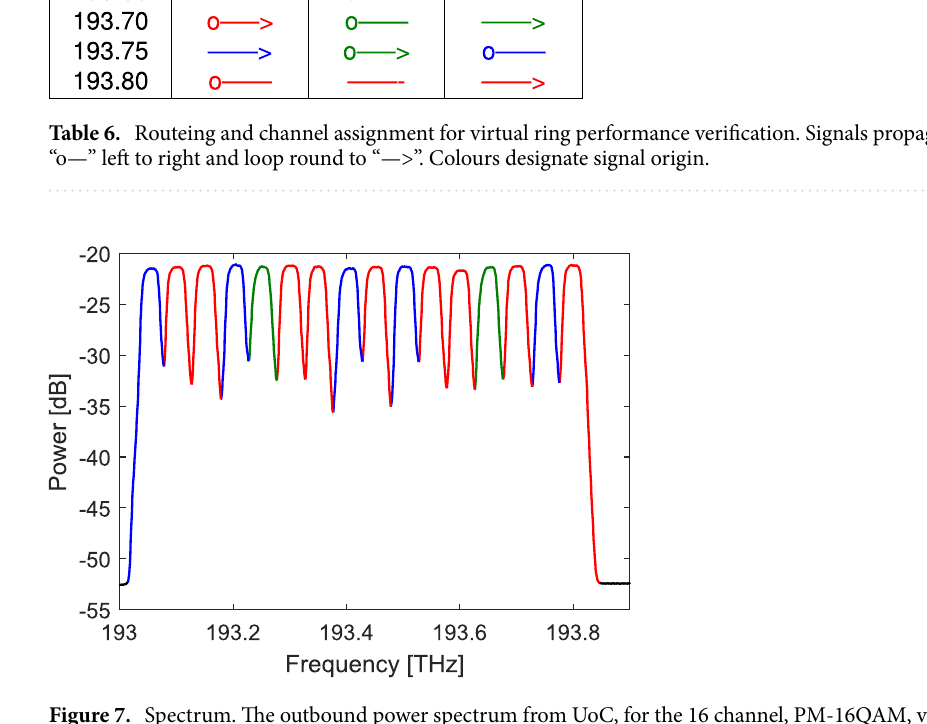
Figure 7. Spectrum. The outbound power spectrum from UoC, for the 16 channel, PM-16QAM, virtual ring verification measurements. Colours designate signal